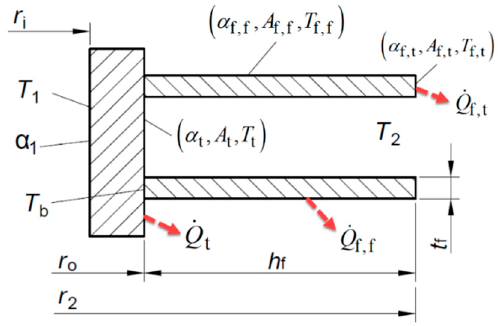
Figure 1. Characteristic dimensions of the finned surface.